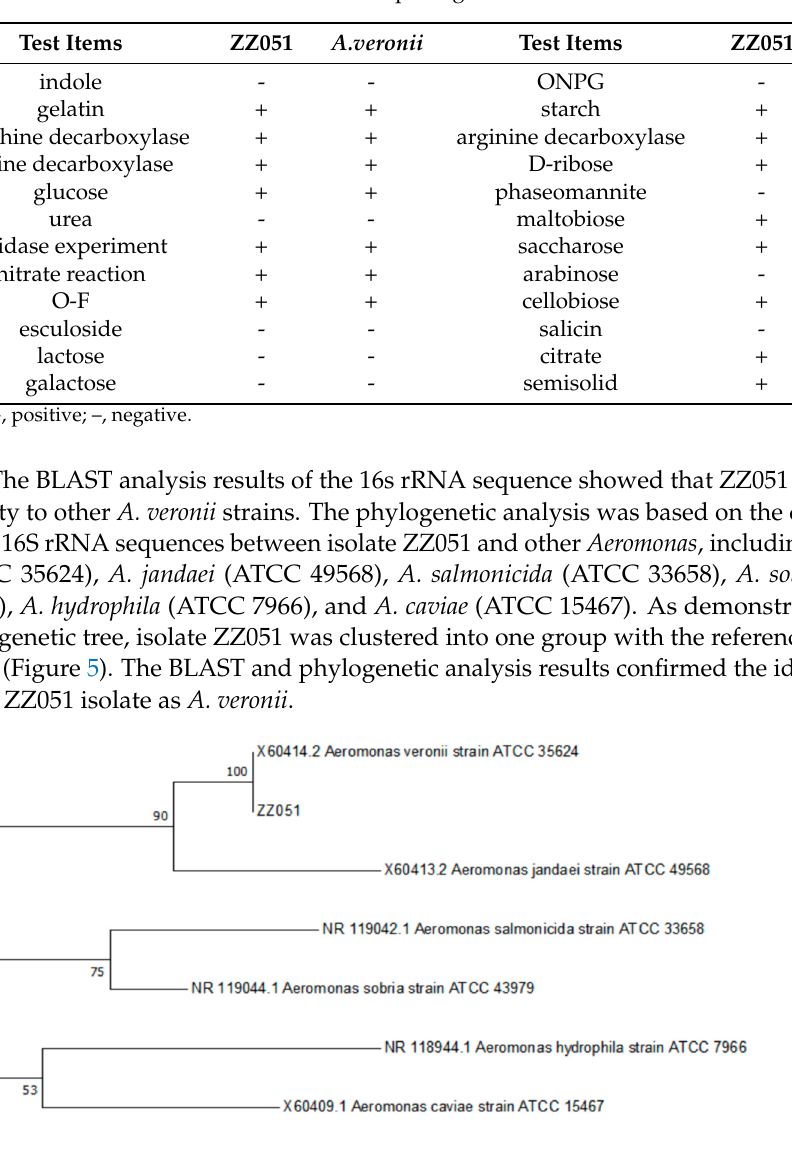
Table 1. The biochemical characteristics of the pathogenic bacteria ZZ051.